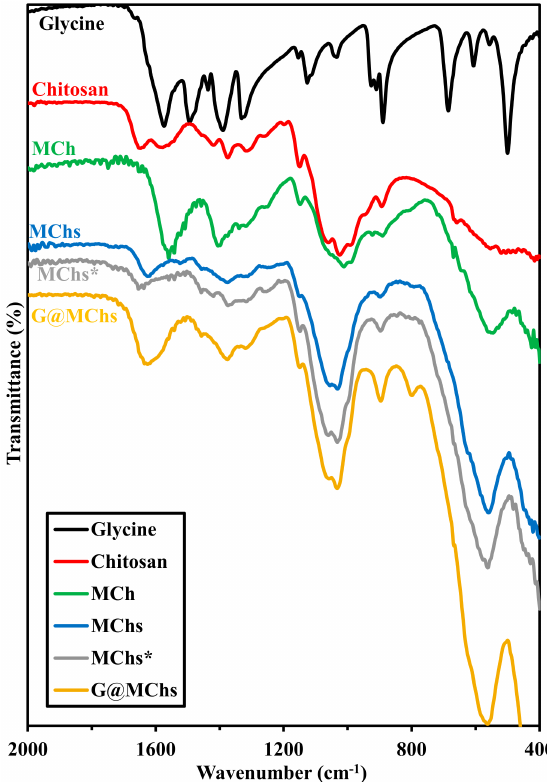
Figure 2. FTIR spectra of glycine, chitosan, and G@MChs sorbents (and intermediary compounds: MCh, magnetic chitosan; MChs, crosslinked magnetic chitosan; MChs*, and activated crosslinked magnetic chitosan with spacer arms) in the wavenumber range: 2000–400 cm − 1